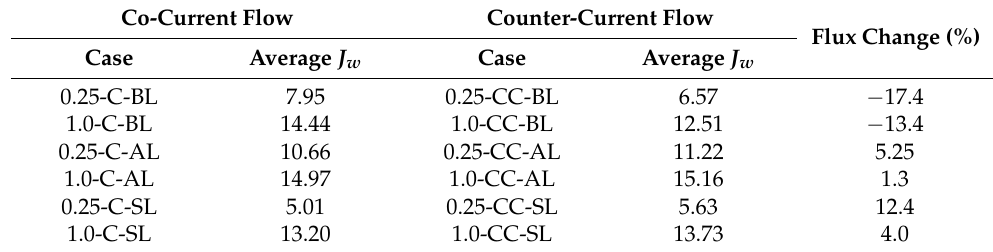
Table 4. Effects of flow configuration on the average water flux (L/m 2 · h) using NaCl draw solution.